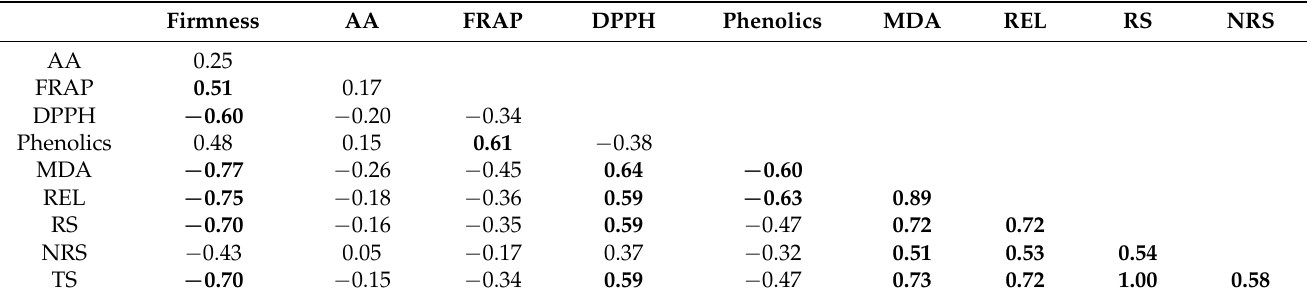
Table 3. Pearson correlation coefficient of AA, FRAP, DPPH, phenolics, MDA, RS, NRS, TS, REL in mango